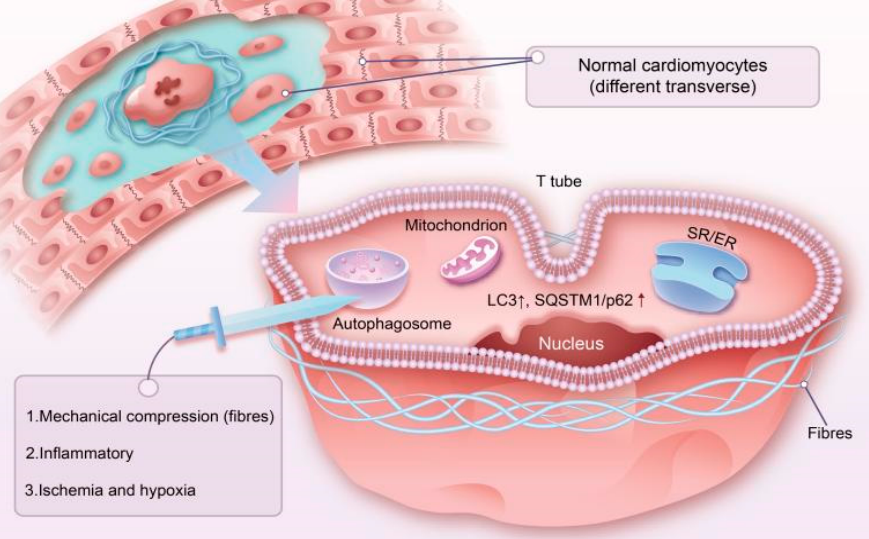
Figure 2. When cardiomyocytes are subjected to long-term injury by external or internal factors (mechanical compression, inflammatory infiltration, ischemia, hypoxia, etc.), cardiomyocytes will gradually perish to form a fibrous encasement around the cardiomyocytes. ACM cells have the pathological process of cardiomyocytes being replaced by fibrofatty tissues, which further creates mechanical compression of normal cardiomyocytes to further aggravate myocardial injury. The internal autophagic mechanism is likely to be the effect of ischemia–hypoxia, a recognized key factor in the initiation of autophagy and heavy mechanical compression of cardiomyocytes in close proximity to the fibrous envelope, further leading to endoplasmic reticulum stress. LC3 ↑ , the gold standard for the detection of autophagy within cardiomyocytes, and SQSTM1/p62 ↑ suggest that the autophagic pathway is activated or blocked.